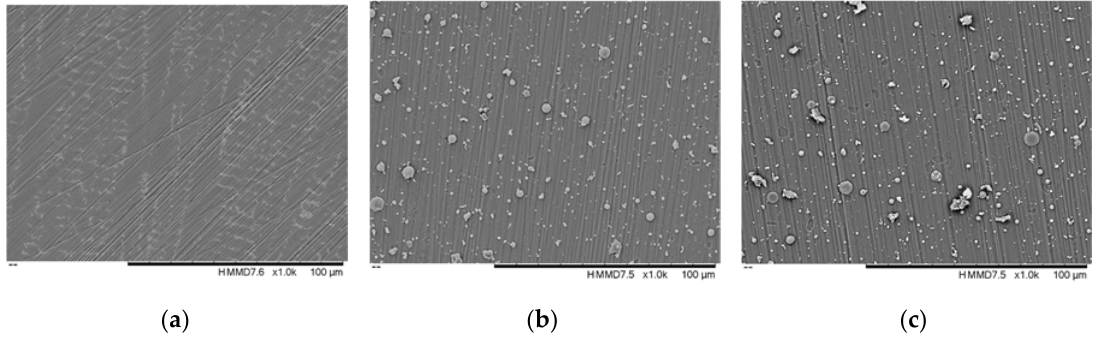
Figure 2. SEM images of the ( a ) uncoated CoCr substrate and ( b ) TiCN and ( c ) TiSiCN coatings.